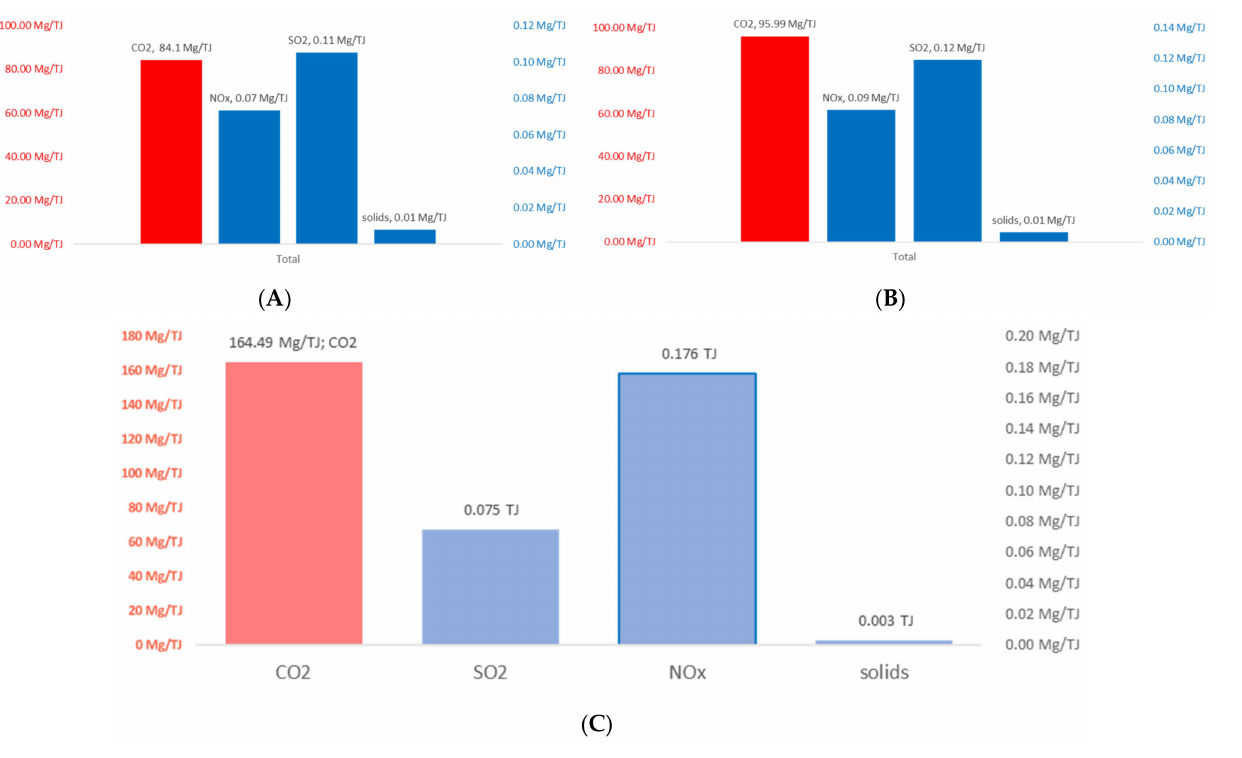
Figure 5. Comparison of total emissions in three Metropolises. ( A ) Emission levels in the GZM Metropolis: total emissions. ( B ) Emission levels in Warsaw: total emissions. ( C ) Emission levels in Pozna´n: total emissions. 2019. Own elaboration based on data from Hubgrade in Warsaw and the study reports on the Smart City project.